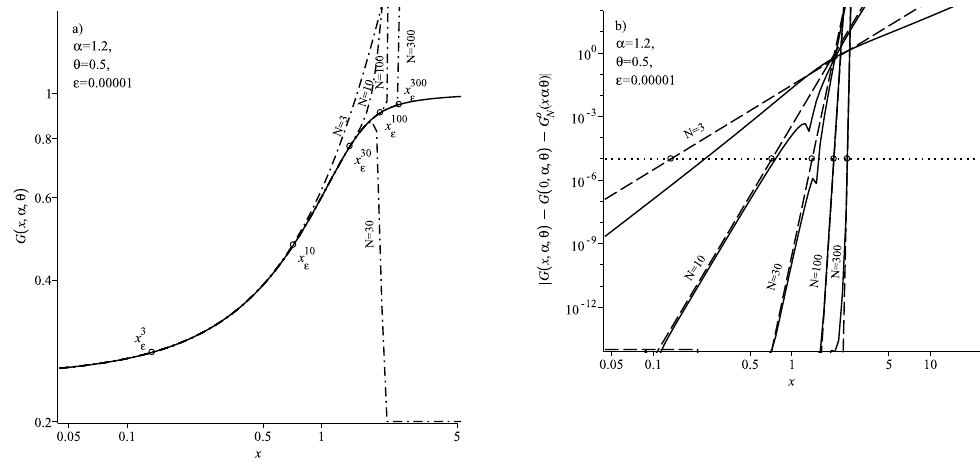
Figure 4. ( a ) Distribution function G ( x , α , θ ) for the parameter values shown in the figure. The solid curve is the integral representation (6), and dash-dotted curves are the expansion (37) for different values of the number of N summands in total. Circles are the position of the threshold coordinate (49) for each value N . ( b ) The graph of the absolute error of calculating the distribution function using the expansion (37) for the case given in Figure ( a ). Solid curves are the exact value of the absolute ( 1 − θ ) − G 0 ( x , α , θ ) | , dashed curves are the estimate (39), the dotted line shows error | G ( x , α , θ ) − 1 N 2 the position of the specified accuracy level ε . Circles demonstrate the location of the threshold coordinate (49) for the specified values of N .